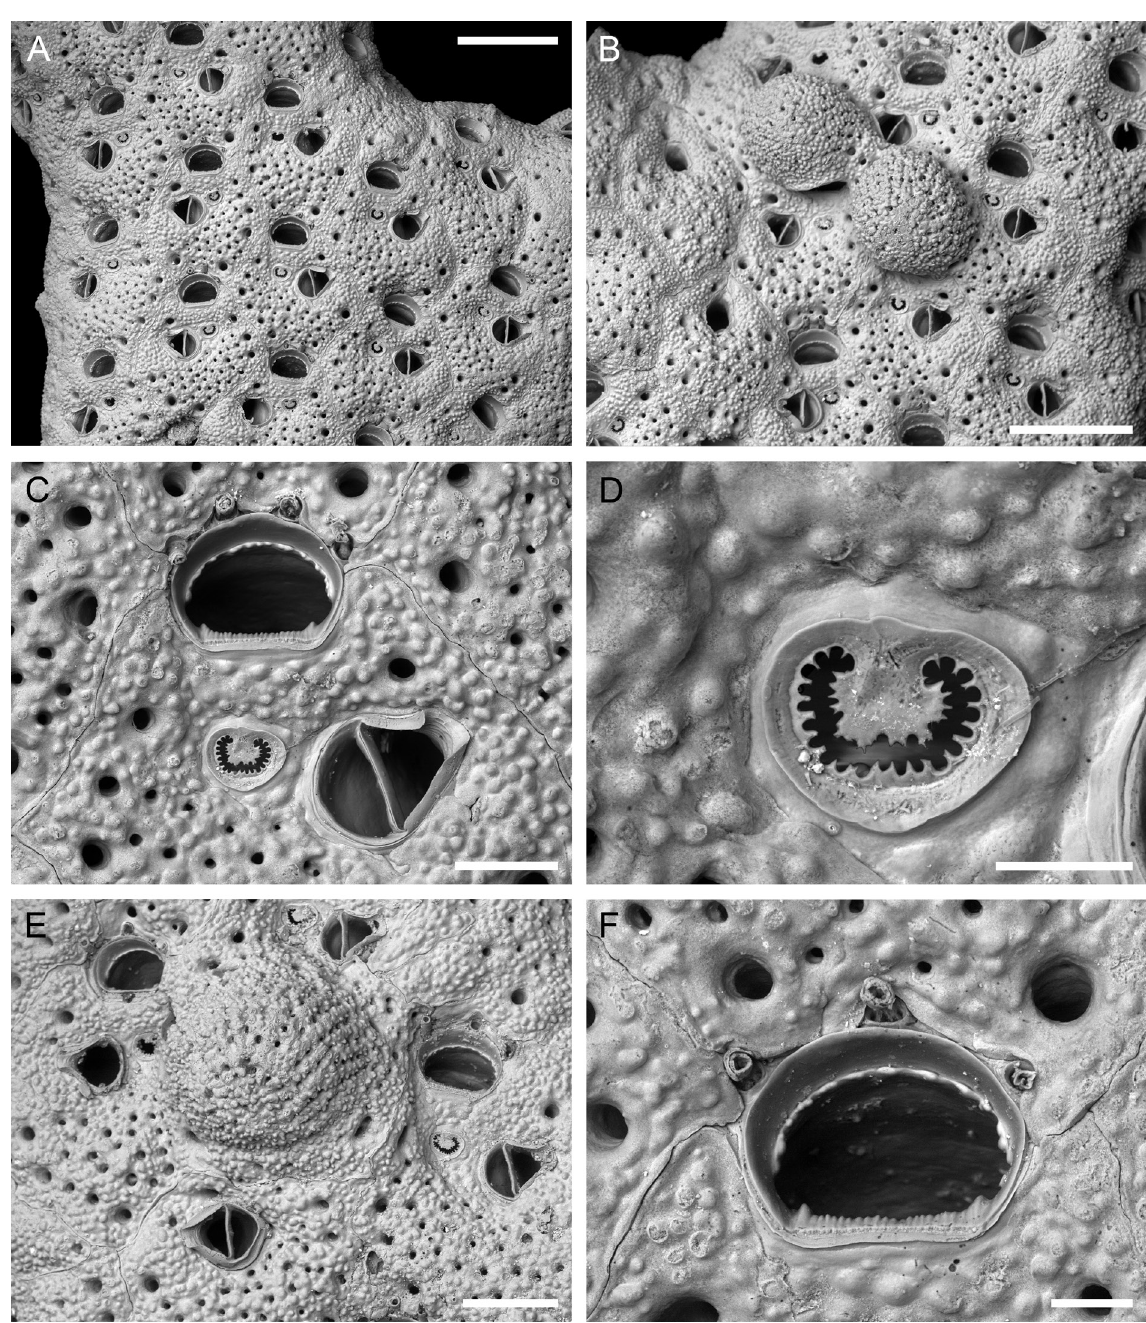
Fig. 5. Microporella hastigera (Busk, 1884), paralectotype, NHMUK 1887.12.9.549a (bleached), Recent, Challenger Expedition, St. 75. A . Group of zooids at branch bifurcation. B . Close-up of two ovicellate zooids with coalescent ovicells. C . Close-up of an orifice with four oral spine bases distally, ascopore and avicularium. D . Close-up of the ascopore. E . Ovicellate zooid with sealed orifice. F . Close- up of an orifice with three oral spine bases distally. Scale bars: A–B = 400 µm; C = 100 µm; D = 40 µm; E = 200 µm; F = 50